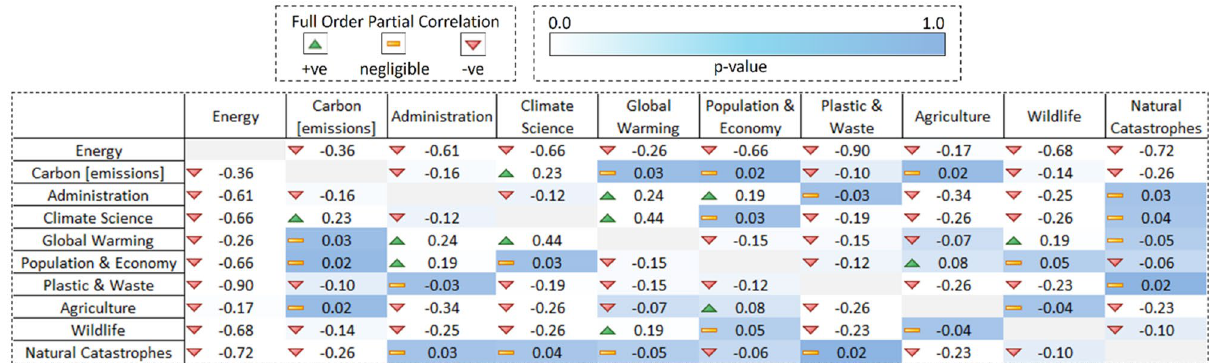
Figure 15. Optimum clusters full order partial correlation matrix with p values. The figure ( a ) shows the full order partial correlations for 10 unique climate change related themes as identified. The up arrow in green signifies a positive partial correlation between the two clusters whereas the down arrow in red signifies a negative partial correlation between the pair. The background colour of the cell represents the p value for the respective partial correlation of a cluster pair ranging from 0 (in white colour) to 1 (in blue